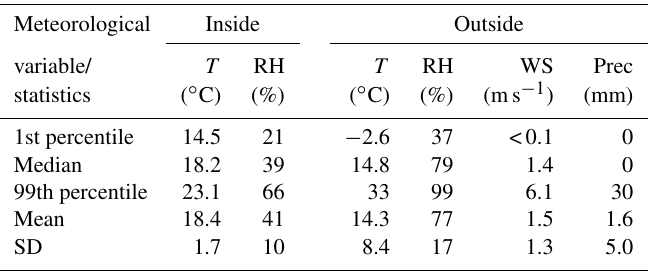
Table 2. Ranges, medians and means with standard deviations for air temperature ( T ), relative humidity (RH), wind speed (WS) and daily precipitation (Prec) inside and outside the BpART facility for 1-year-long ordinary operation in 2013–2014. Meteorological Inside